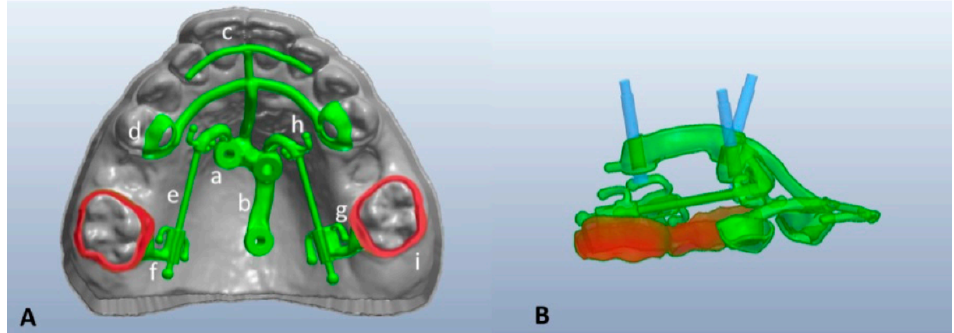
Figure 1. Three-dimensional (3D) design of DIVA (Divergent Anchors) appliance. ( A ) Occlusal view, showing the parts of the appliance: (a) bushing for the miniscrew (b) connecting bar (c) T-shaped rest on incisors (d) occlusal rest on first premolar (e) rod for guiding mesial movement of molars (f) molar tube attached to molar band (g) hook on molar tube (h) hook on rod (i) conventional prefabricated molar band (in orange). ( B ) Lateral view, showing that bushings (green) and miniscrews (light blue) are not parallel among them, and slightly diverge in an apical direction. Not parallel miniscrews prevent any vertical movement of the appliance during the clinical